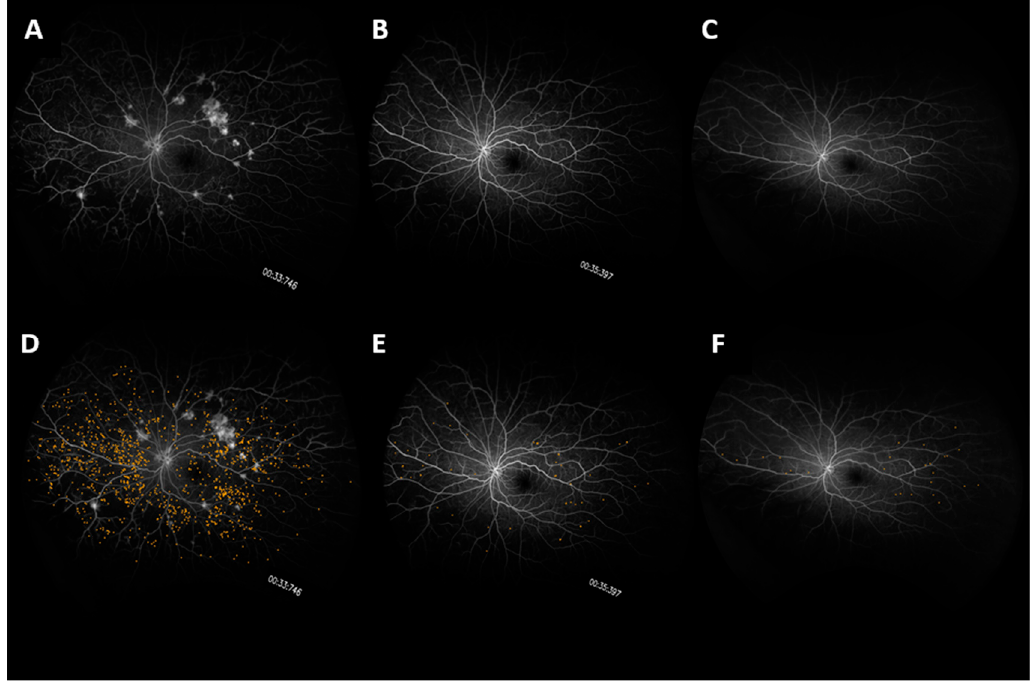
Figure 4. UWFA fundus images of a representative case showing changes in microaneurysm count over time. Fundus images are shown at ( A ) Baseline, ( B ) Year 1, ( C ) Year 3. Microaneurysm mask overlays are shown at ( D ) Baseline, ( E ) Year 1, and ( F ) Year 2.